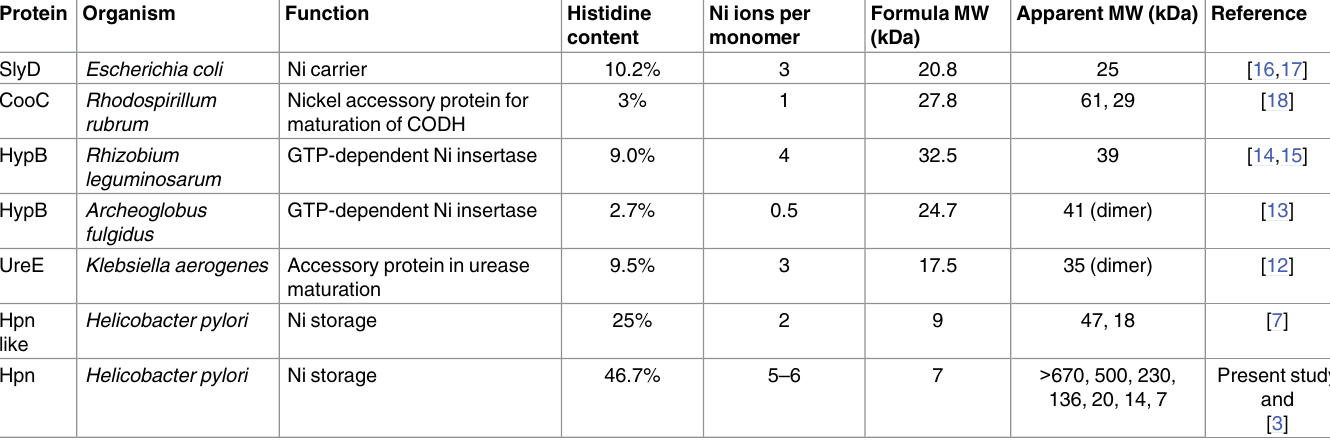
Table 1. List of histidine-rich Ni 2+ -binding proteins showing gel shifting anomaly. Protein